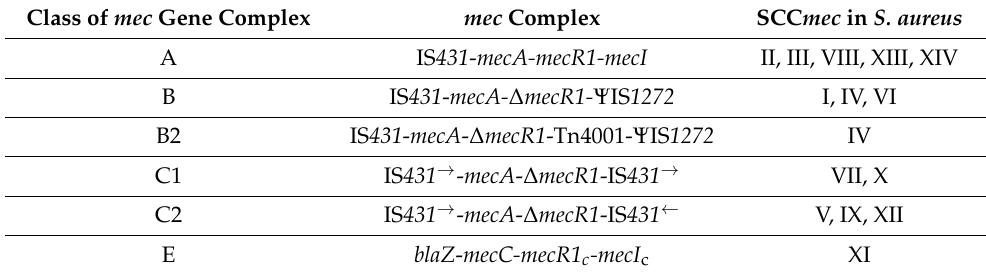
Table 1. The mec gene complexes in S. aureus .